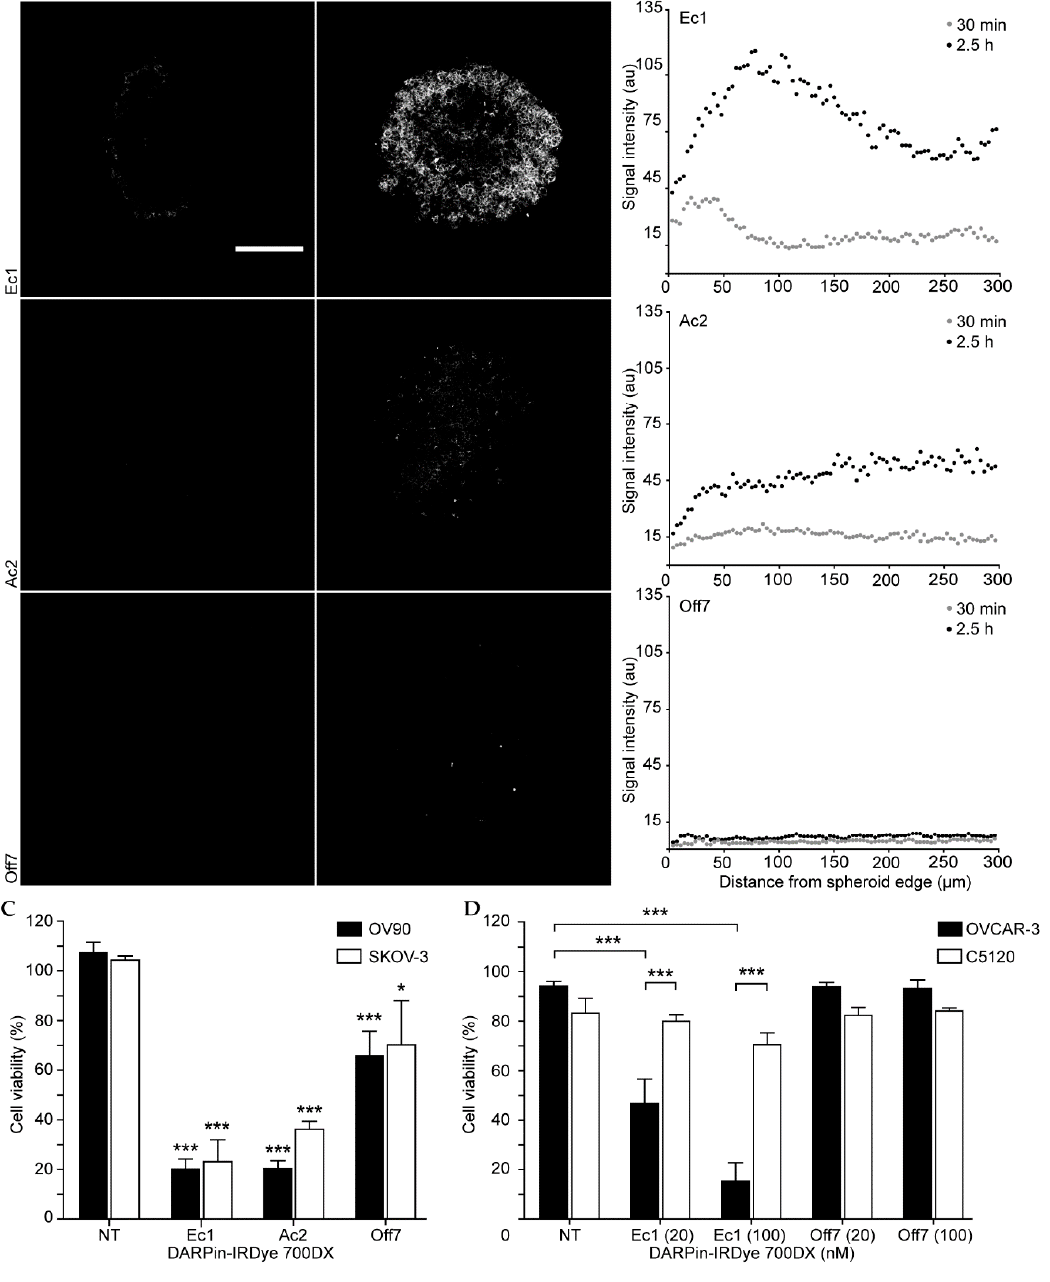
Figure 4. DARPin penetration and phototoxicity in 3D culture models. ( A ) DARPin uptake in a spheroid model of OV90 cells. DARPins were incubated for 30 min or 2.5 h and imaged with confocal microscopy after a SeeDB clearing protocol to enable visualization of fluorescence throughout the spheroid. Z-stacks are provided in Figure S7. The scale bar denotes 200 µm. ( B ) Quantification of the signal intensity from DARPin uptake in spheroids. Each data point represents the measurement of the average signal intensity at the indicated distance from the spheroid rim. For each condition, a representative spheroid was used for quantitative analysis. ( C ) Spheroids from both OV90 and SKOV-